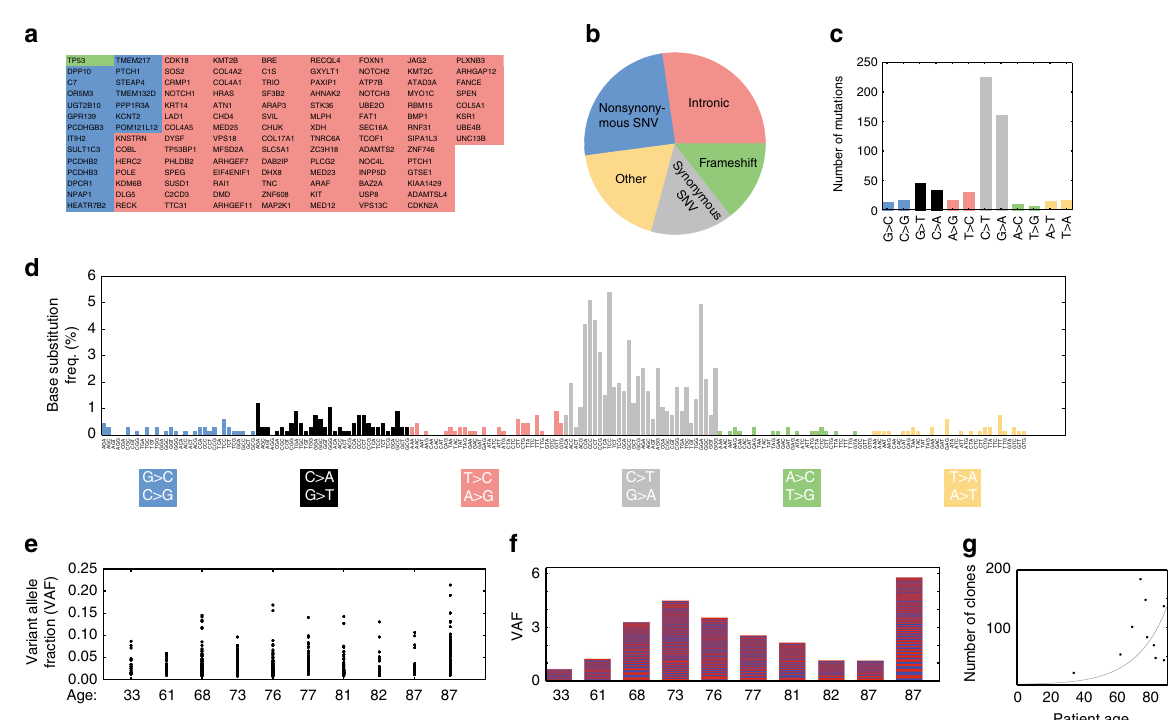
Fig. 1 Identi fi cation of clonally expanded mutations in human epidermis. a Identity of genes included in capture oligonucleotide set. Genes frequently mutated in SCC (red) BCC (blue) or both (green) were included. b Genomic context of mutations identi fi ed by capture sequencing. c Number of base substitutions on the coding strand. The dominance of C > T transitions is characteristic of UV light-induced mutagenesis. The excess of C > T over G > A is a characteristic of transcription-coupled repair. d Base substitutions plotted according to trinucleotide context on the coding strand. e Mutant clone size distribution for each patient. The size of each mutant clone identi fi ed (variant allele fraction, VAF) is indicated. Each fi lled circle indicates a single mutant clone. f Cumulative clone size distributions for each patient. Clones are stacked in order of size with largest at the base of the column. Even clones are blue and odd red. g Relationship between mutant clone distribution and patient age. Each point represents the number of clones identi fi ed for a single patient. An exponential line of best fi t is